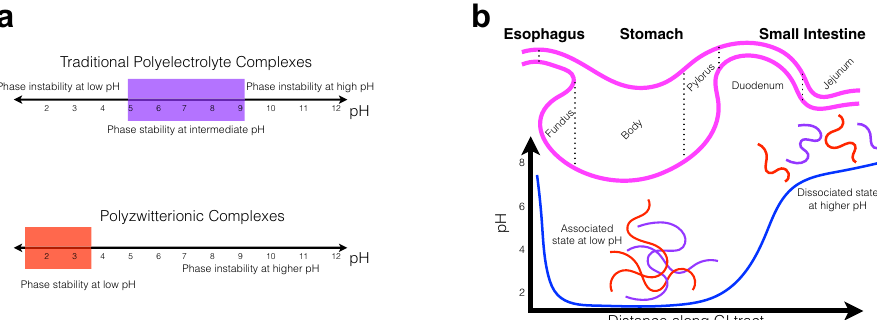
Fig. 1 Orthogonal phase behavior of polyzwitterionic complexes and their applicability to gastrointestinal cargo delivery. a Comparing the phase behavior of traditional polyelectrolyte complexes (top, purple box) with polyzwitterionic complexes (bottom, red box). In traditional systems, phase stability (i.e., the parameter space in which stable complexation can occur) is present at intermediate pH values (purple box) because of the p K a values of the constituent chains. Maximal complexation occurs when both positive and negative chains are maximally charged, typical values for which are found within the purple box. In contrast, with polyzwitterionic complexes, stable spherical droplets are formed when the pH is in a more acidic range (red box). b Schematic diagram of pH variation along the GI tract and design principle. Inside the acidic environment of the stomach, polyzwitterionic complexes would remain in their associated state. As they move into the duodenal space, the pH (blue line) rapidly increases to a value of 6 – 8, which would result in